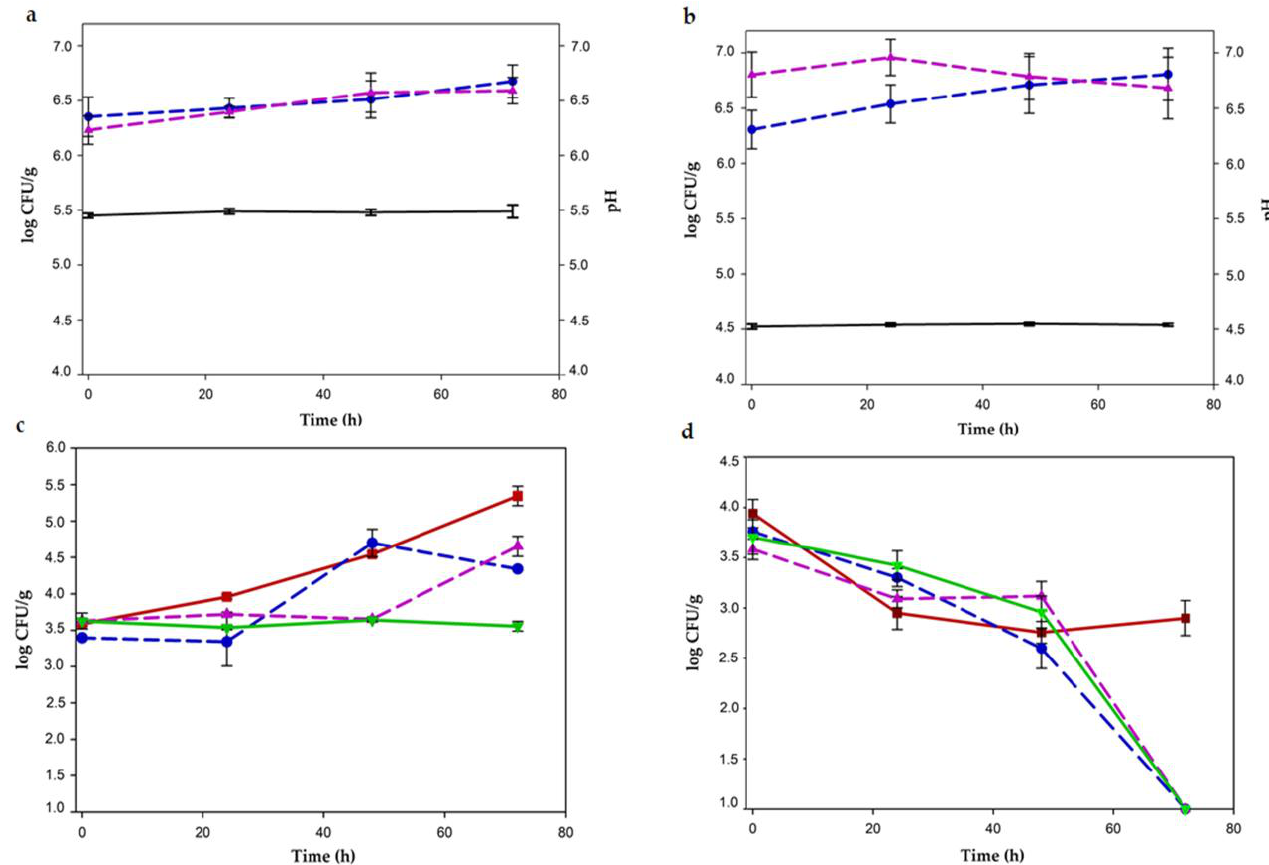
Figure 2. LAB and EHEC growth kinetics (log CFU/g) in individual culture and in co-culture on meat discs at 8 °C. ( a ) pH (black line) and individual growth of L. plantarum CRL681 (blue dotted line) and E. mundtii CRL 35 (magenta dotted line) without lactic acid (LA). ( b ) pH (black line) and individual growth of CRL681 (blue dotted line) and CRL35 (magenta dotted line) with the addition of 0.6% LA. ( c ) EHEC growth in individual culture (red line) and influenced by the presence of LAB ( L. plantarum + EHEC, blue dotted line; E. mundtii + EHEC, magenta dotted line and L. plantarum CRL681 + E. mundtii CRL35 + EHEC, green line) without the addition of LA. ( d ) Viability of EHEC in individual culture (red line) and in co-culture in the presence of LAB ( L. plantarum + EHEC, blue dotted line; E. mundtii + EHEC, magenta dotted line and L. plantarum CRL681 + E. mundtii CRL35 + EHEC, green line) with the addition of 0.6% LA.